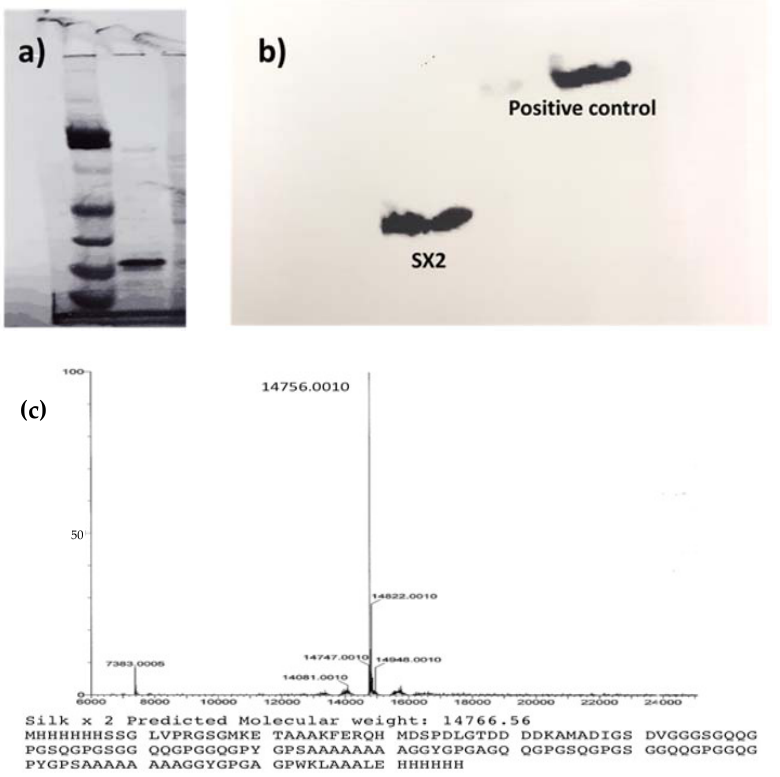
Figure 2. ( a ) SDS-PAGE of the purified protein showing the band at 15 kDa, ( b ) Western blot of the protein against an anti-his antibody confirms the production of the protein, ( c ) theoretical mass was predicted to be 14,766 Da while mass spectrometry of the silk protein was determined to be 14,756 Da.